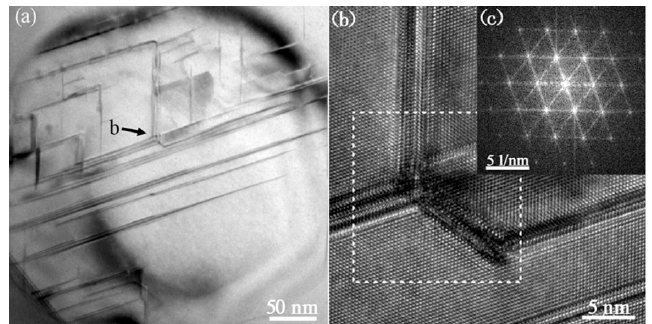
Figure 3. TEM image of eutectic Si in Al–10Si–0.015Sr alloy, ( a ) TEM bright–field image, ( b ) atomic lattice image at the intersection of twins as denoted by b arrow in ( a ), and ( c ) FFT image of denoted zone in dashed box.